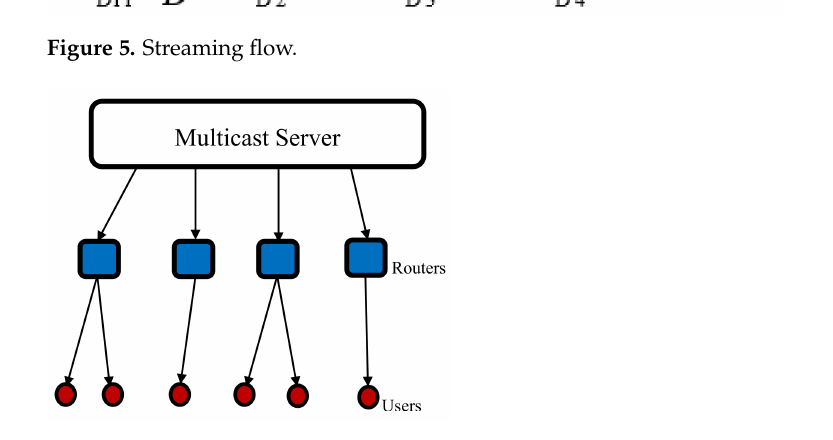
Figure 6. Multicast